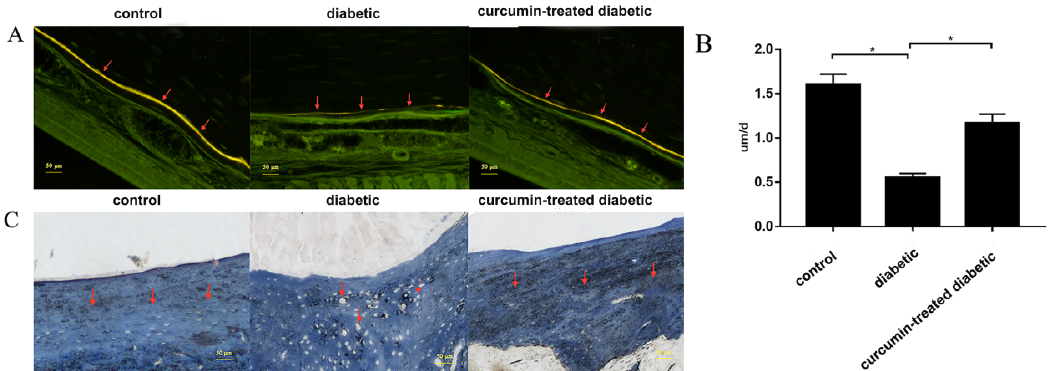
Figure 4. Evaluation of the osteogenic effect of curcumin on bone formation in vivo. ( A ) Fluorescent microscopy images of alveolar bone in non-diabetic (control), diabetic, and curcumin-treated groups, respectively. Alveolar cortical bone continuity and thickness improved in the db/db + C group compared with that in the db/db group, which was similar to that of the db/m group. ( B ) The bar chart shows the rate of trabecular formation. * p < 0.05. ( C ) Masson staining images of alveolar bone in non-diabetic (control), diabetic, and curcumin-treated groups, respectively. Alveolar cancellous bone density and mineralization improved in the db/db + C group compared with that in the db/db group, which was similar to that of the db/m group.